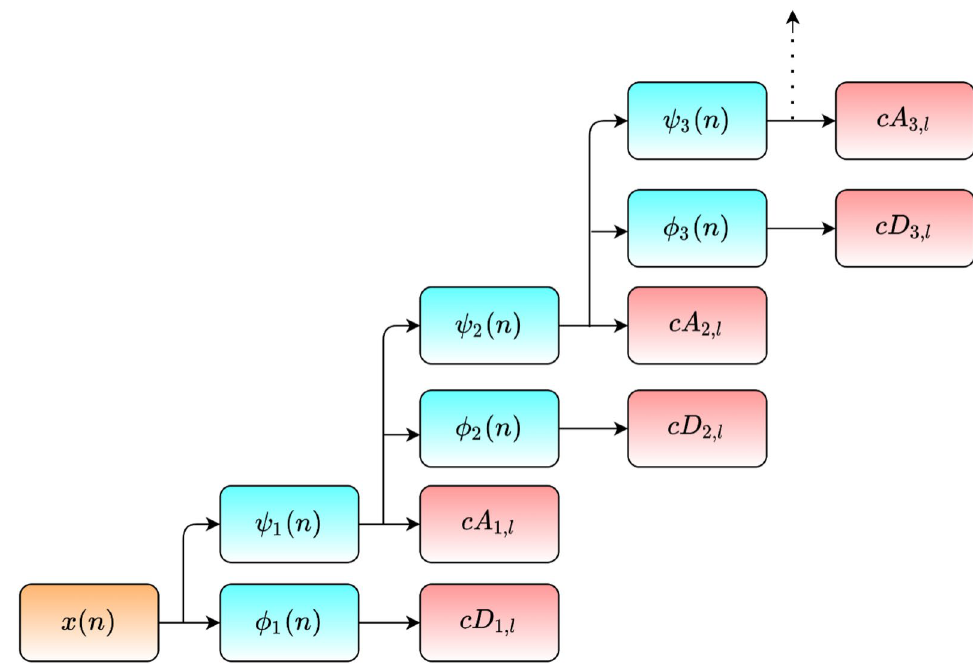
Figure 2 Schematic representation of a level-3 decomposition of a THz time-domain signal with the